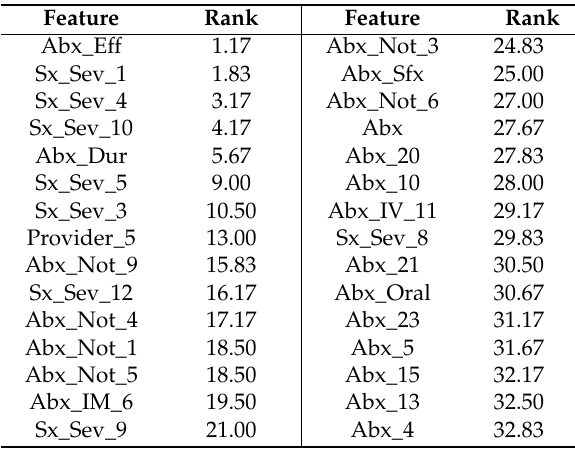
Table 2. Top feature ranks.